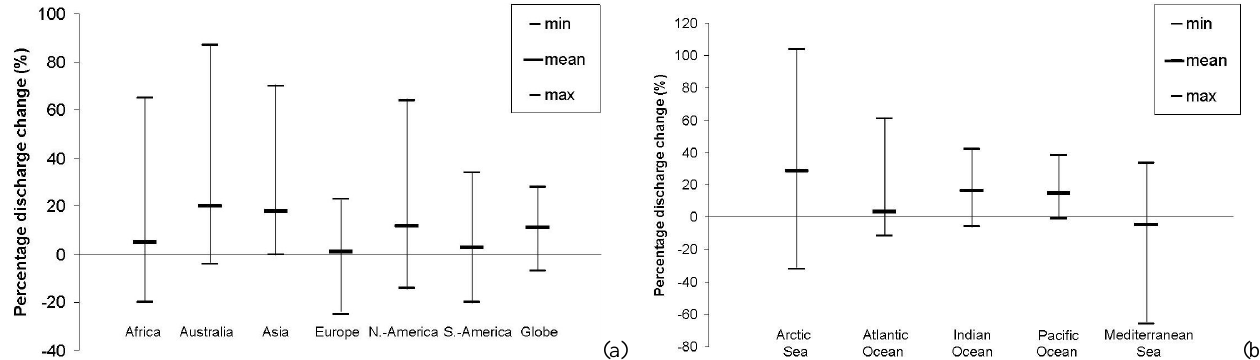
Fig. 9. (a) Continental discharge changes (%), (b) change in freshwater inflow to oceans (%). Vertical bars represent range of changes covered by the entire ensembles of GCMs, large horizontal dashes represent ensemble mean change, small horizontal dashes represent minimum and maximum projected changes. Table 3. Change in global temperature (K), precipitation (%) and discharge (%) for different emissions scenarios. Temperature Ensemble Ensemble Ensemble Horizon Source min mean